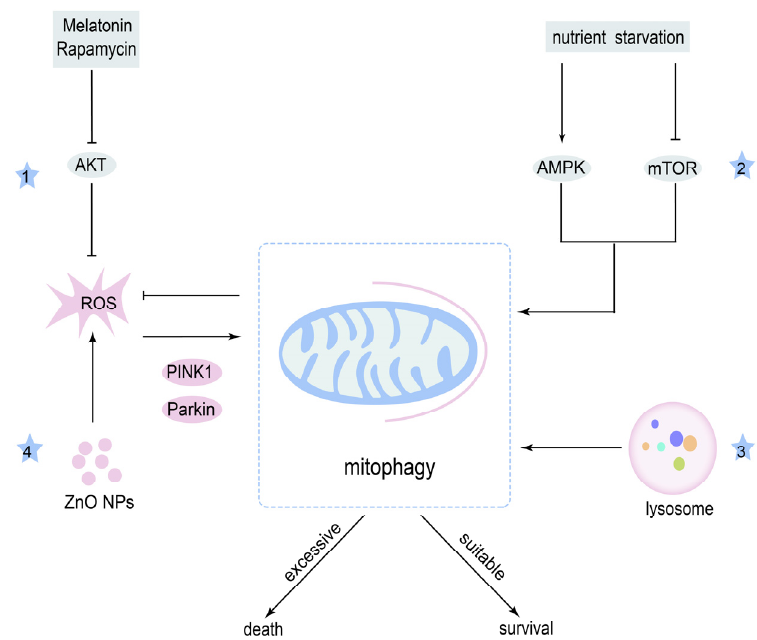
Figure 5. Mechanism of mitophagy in OSCC therapy and resistance. Mitophagy can reduce the influence of (1) ROS and (2) nutrient deficiency, thereby contributing to the survival of OSCC cells. Inhibiting the function of (3) lysosomes or excessive mitophagy induced by (4) Zinc oxide NPs (ZnO NPs) can cause OSCC cell death.